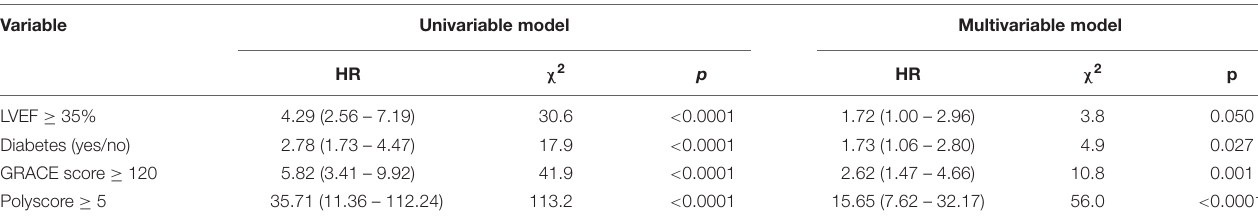
TABLE 3 | Cox regression model using dichotomised